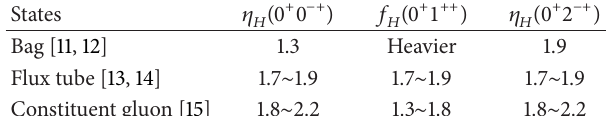
Table 4: The masses predicted for 𝜂 𝐻 (0 + 0 −+ ),𝑓 𝐻 (0 + 1 ++ ) and (0 + 2 −+ ) hybrid states in [11–15]. 𝜂 𝐻